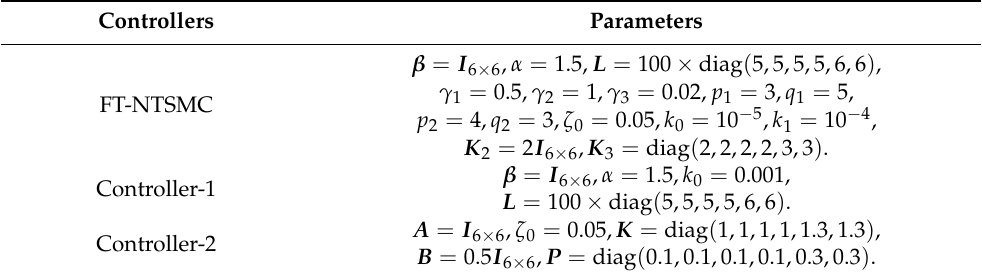
Table 2. Parameters of the three controllers for the CPR.